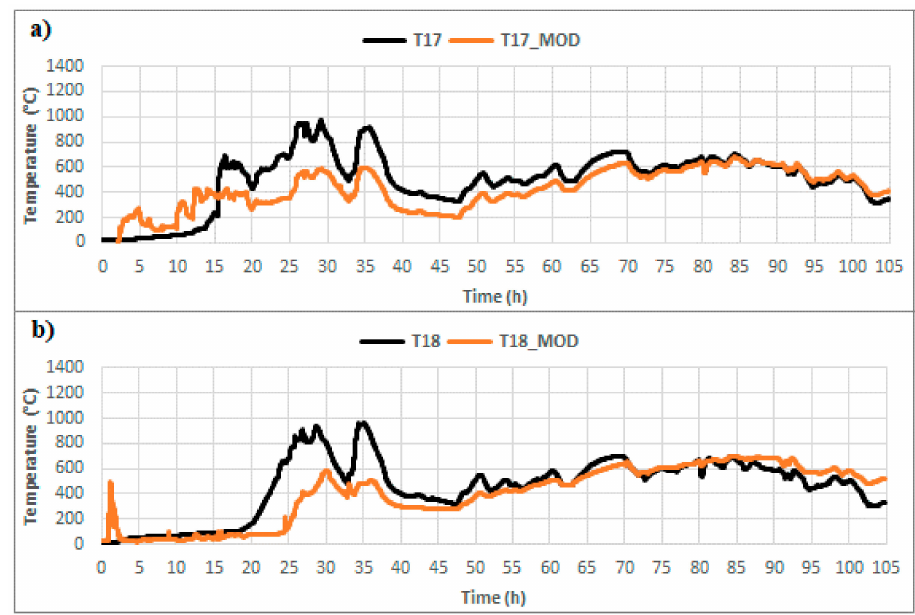
Figure 21. The measured (T) and modeled (T_MOD) temperature behavior in the first phase ver- ification by using modified regression models, ( a ) temperature T 17 , ( b ) temperature T 18 (Source: own elaboration).